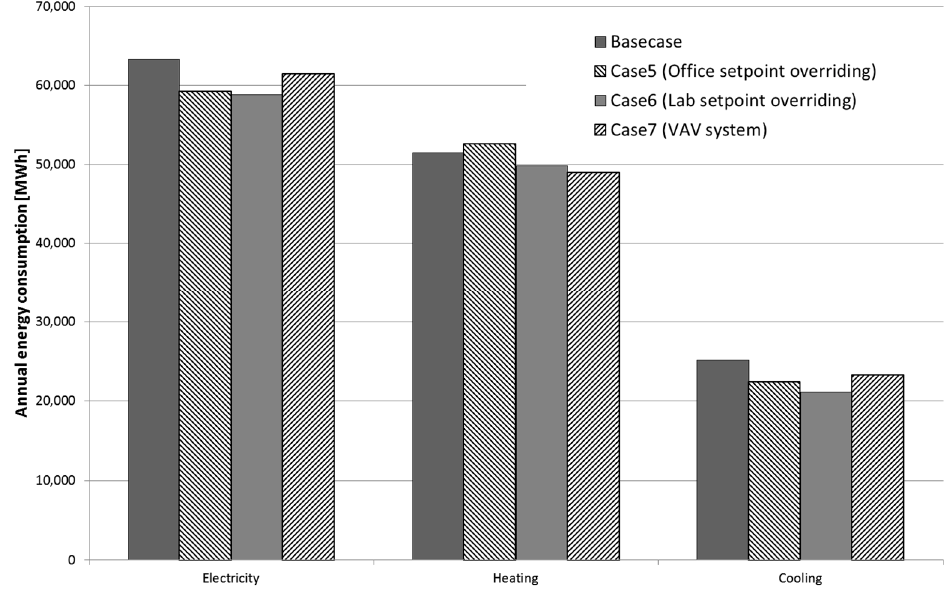
Figure 9. Annual energy saving potentials by demand management and HVAC system retrofitting.